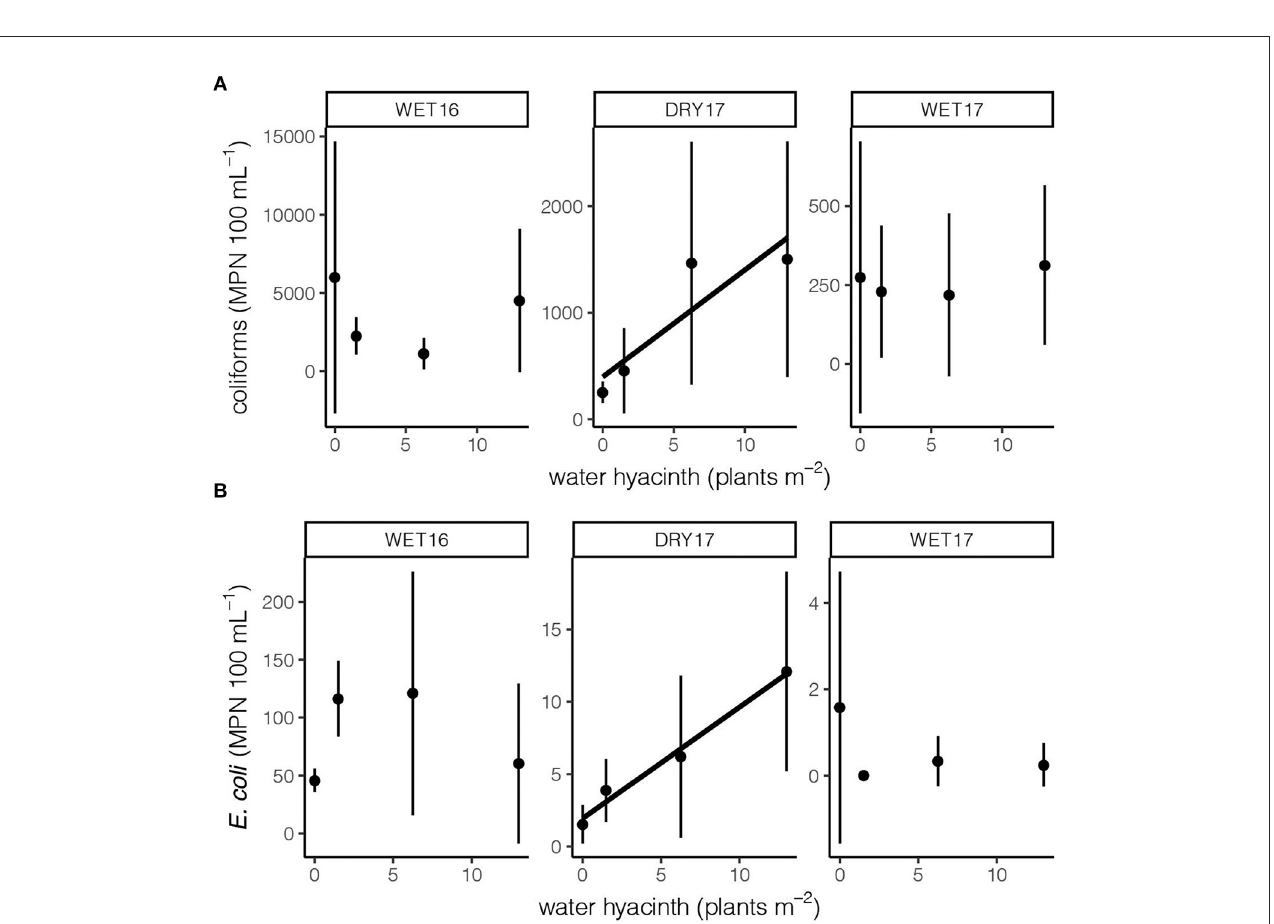
FIGURE5 The impact of water hyacinth density on (A) total coliform concentrations and (B) E. coli concentrations were only evident during the March/April experiment (DRY17). The black line indicates a significant relationship between water hyacinth density and fecal parameter ( p < 0.05). Note differences in scale among